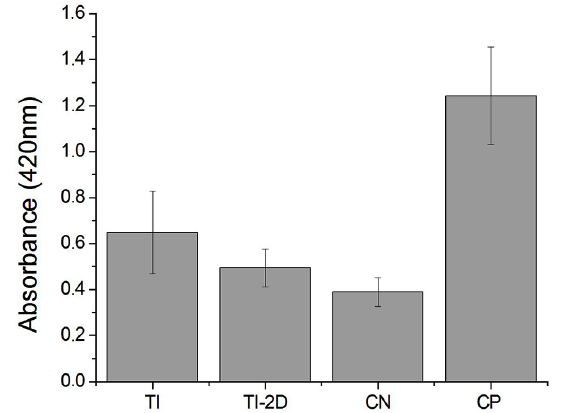
Figure 6 - HDL results.